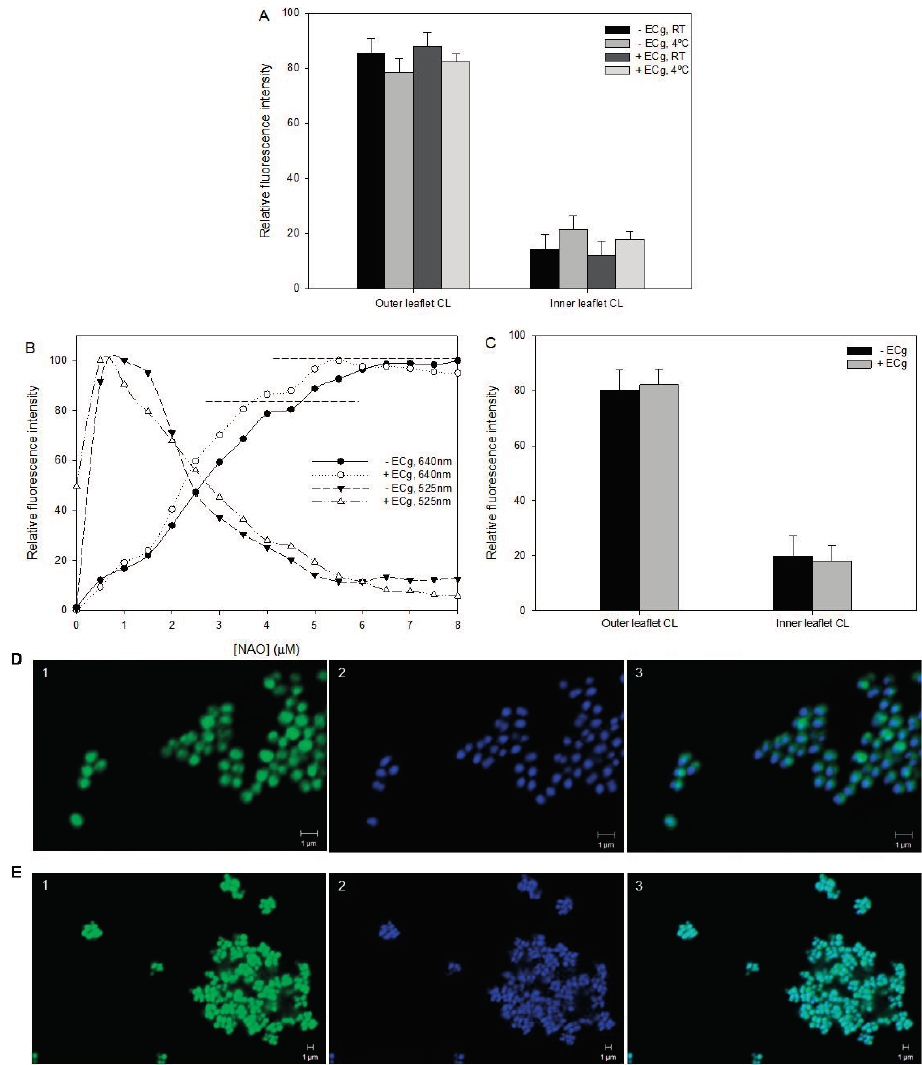
Figure 4. CL is asymmetrically distributed between the outer and inner leaflets of the EMRSA-16 CM and is unaffected by intercalation of ECg into the bilayer. ( A ) Relative fluorescence intensity of 18:1–18:1 NBD-CL labelled EMRSA-16 in the absence or presence of 12.5 µg/mL ECg. Fluorescence emission was determined after 30 min exposure at RT and 4 °C to the lipid analogue followed by dithionate quenching ( n = 5). RT, room temperature; ( B ) Relative fluorescence intensity of CL in the EMRSA-16 CM in the absence (closed symbols) or presence (open symbols) of 12.5 µg/mL ECg, as determined by NAO titration. Fluorescence emission was read at 525 nm (decreasing fluorescence) and at 624 nm (increasing fluorescence) after 20 min cell exposure to the dye at 4 °C. NAO binds initially to outer leaflet CL until saturation at approximately 4–4.5 µM NAO, and then to the inner leaflet CL until complete saturation at approximately 5.5 µM NAO. The transition is marked by horizontal lines; ( C ) Quantification of CL present in the outer and inner leaflets of the EMRSA-16 CM ( n = 5). No significant differences between control and ECg-grown bacteria with either method: p > 0.1; two-tailed Student’s t ; CLSM of EMRSA-16 in the ( D ) absence and ( E ) presence of 12.5 µg/mL ECg; cells labelled with (1) 5 µM NAO, (2) 5 µM Hoescht 33342 and images merged (3). Scale bars 1